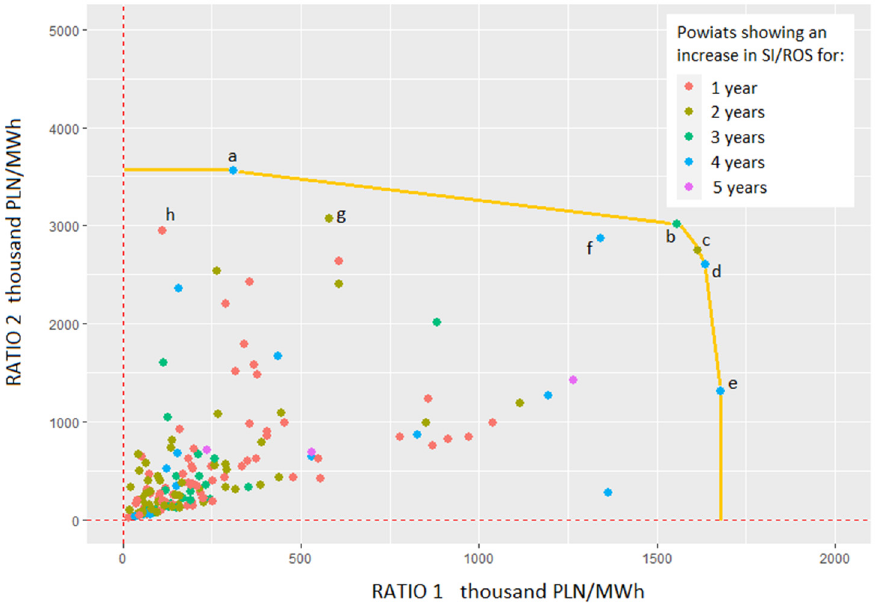
Figure 5. Relative efficiency of the powiats for the period 2014–2020 for food business operators.